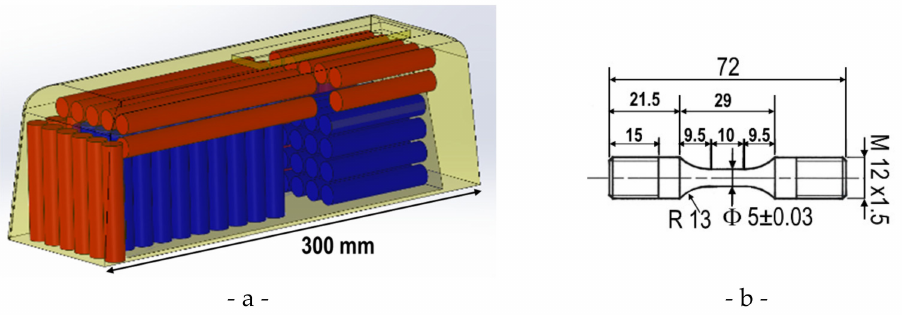
Figure 4. ( a ) Type 100 ingot with indication of wire cutting positions (skin in red, core in blue) for cylindrical bars. ( b ) Tensile and fatigue sample